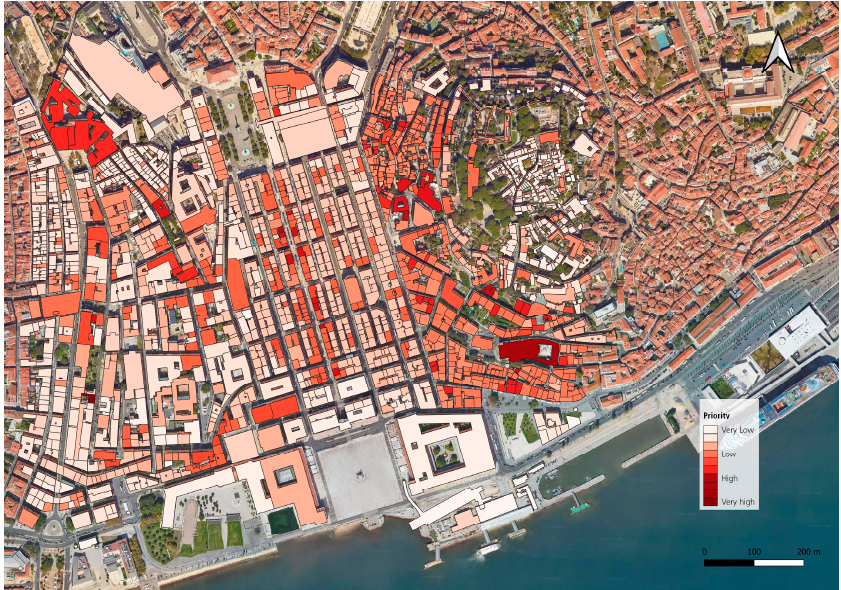
Figure 15. Map outlining the priorities for intervention in the historic center of Lisbon.